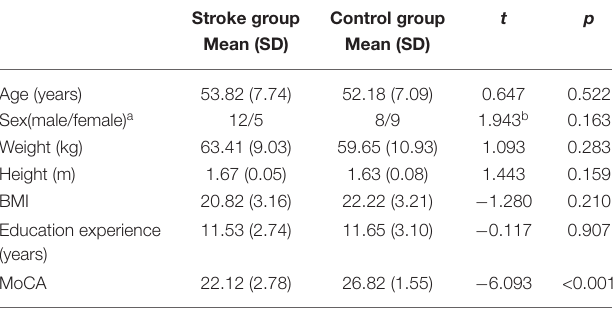
TABLE 1 | Descriptive characteristics of the two groups of